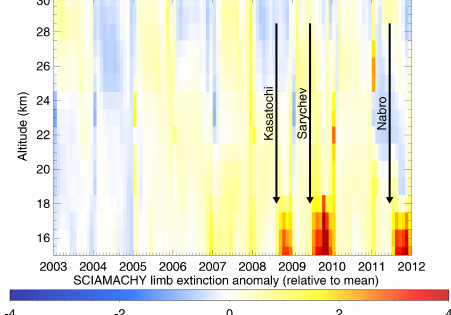
Figure 15. As Fig. 14 but for SCIAMACHY limb data at